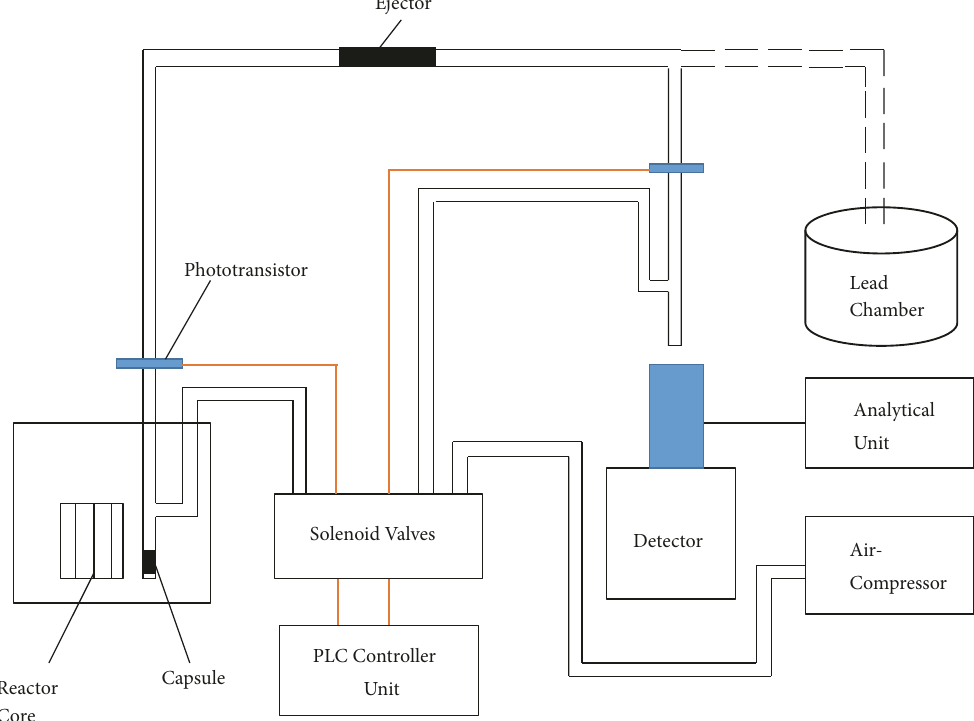
Figure 1: Schematic diagram of cyclic neutron activation analysis